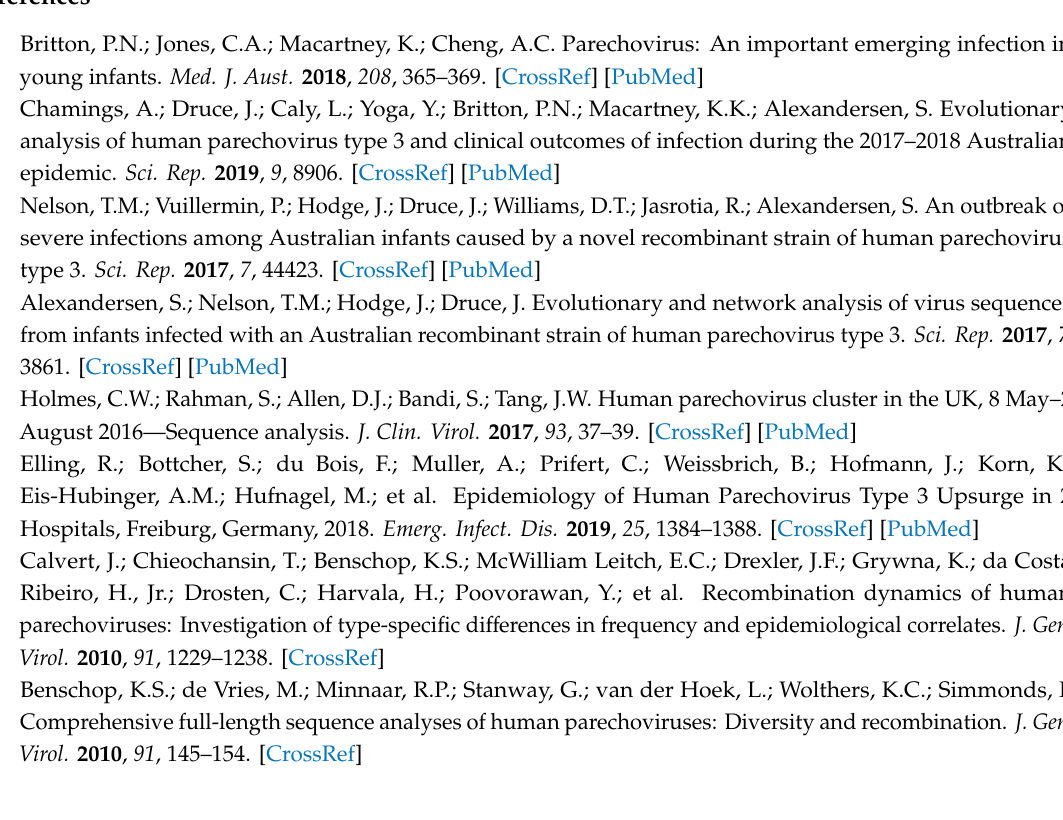
Figure S1: Maximum likelihood tree of 567nt of all HPeV5 VP1 sequences available on GenBank, August